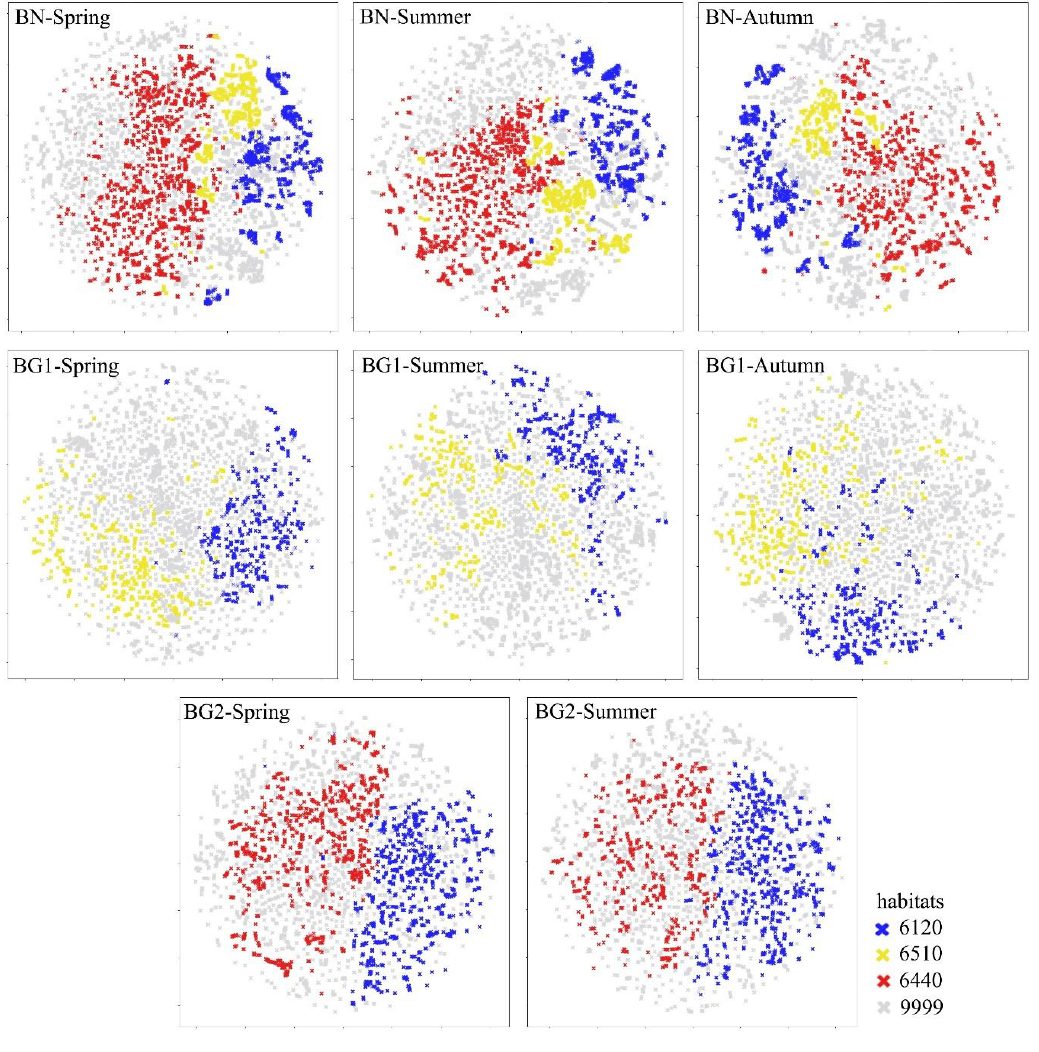
Figure 4 . Example of t-SNE visualization, colors are assigned based on different habitat classes. Axes represent multidimensional space distances without specific units, therefore are omitted. Table 1. Number of reference polygons for each habitat class and study area.